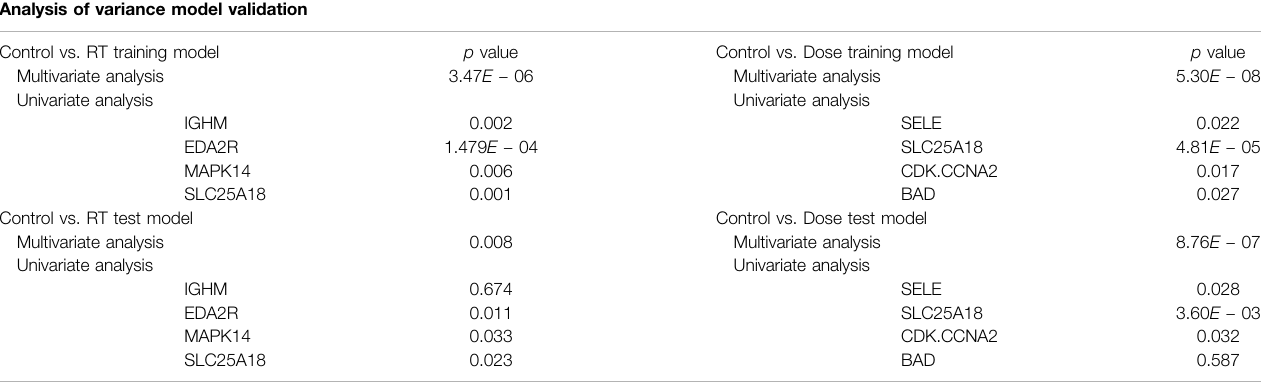
TABLE 1 | Model Validation Analysis of Variance. Models were validated using both multivariate analysis of variance (MANOVA) and univariate analysis of variance (ANOVA) for both the Control vs. RT and Control vs. Dose training and test models. p -values represent the Pr ( > F), the p -value of the given effect and F statistic. Analysis of variance model validation Control vs. RT training model